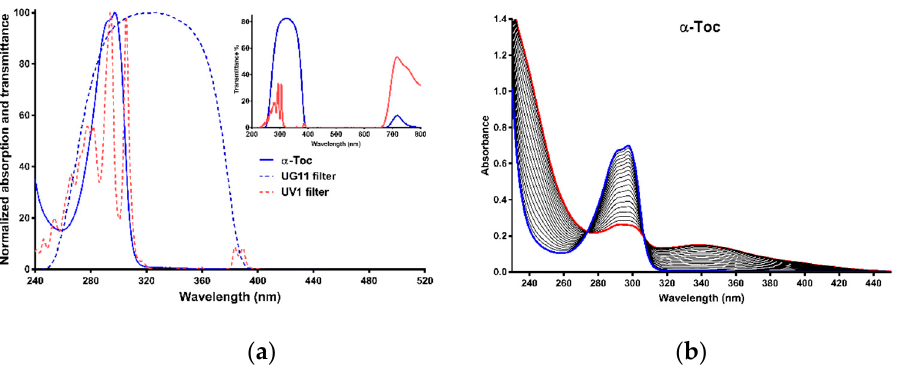
Figure 1. ( a ) Normalized absorption spectra of α -Toc and normalized transmittance spectra of band pass filter used. Inset—transmittance spectra of filters in full UV+Vis range. ( b ) Time-course of absorption spectra of α -Toc. Blue line—initial spectrum, red line—final spectrum. Irradiation time 421 min, optical path—1 cm.